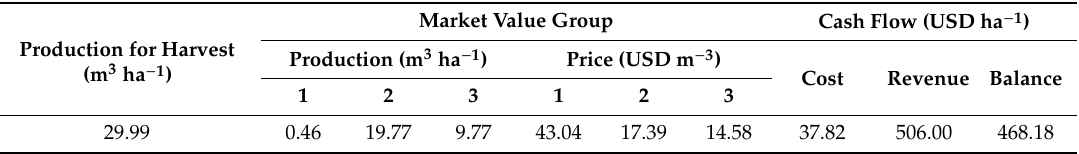
Table 2. Current values of forest management activity. Production for harvest and sales prices of standing timber, market value group, and cash flow for Shet Farm, Dom Eliseu, Pará, Brazil.